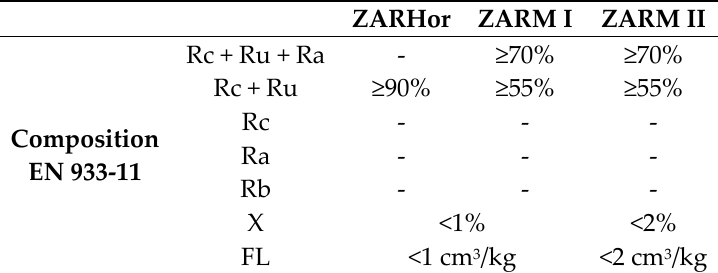
Figure 1. Types of structural sections recommended in the catalogue. * MB = Bituminous mixture. Table 1. Classification of recycled well-graded granular materials according to composition